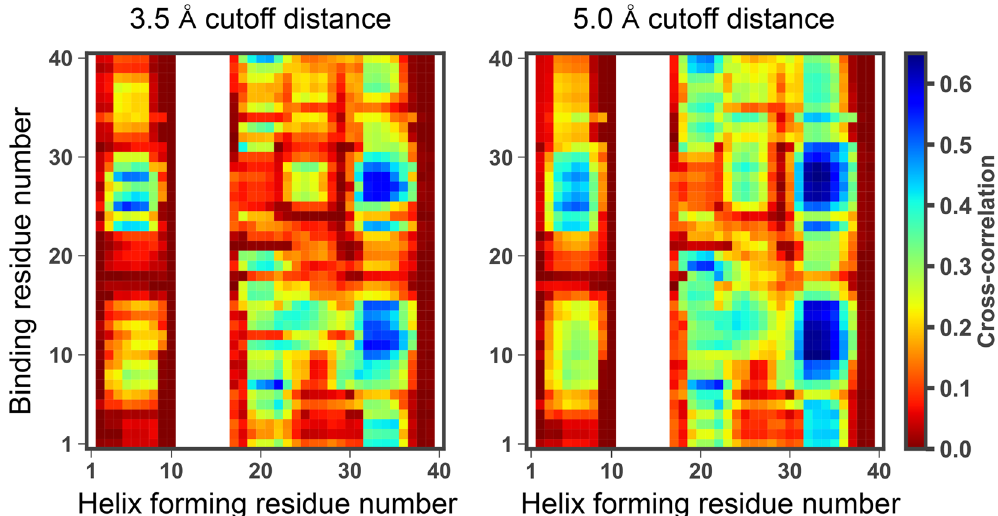
Figure 8. Matrices of cross-correlation C ij between helix formation and binding to the GM1-glycan cluster in each amino acid residue with different cutoff distances, 3.5 and 5.0 Å. These values were calculated from all of the subsampled MD trajectories. White color means that residues correspond to the abscissa did not form helix structures during all MD simulations.